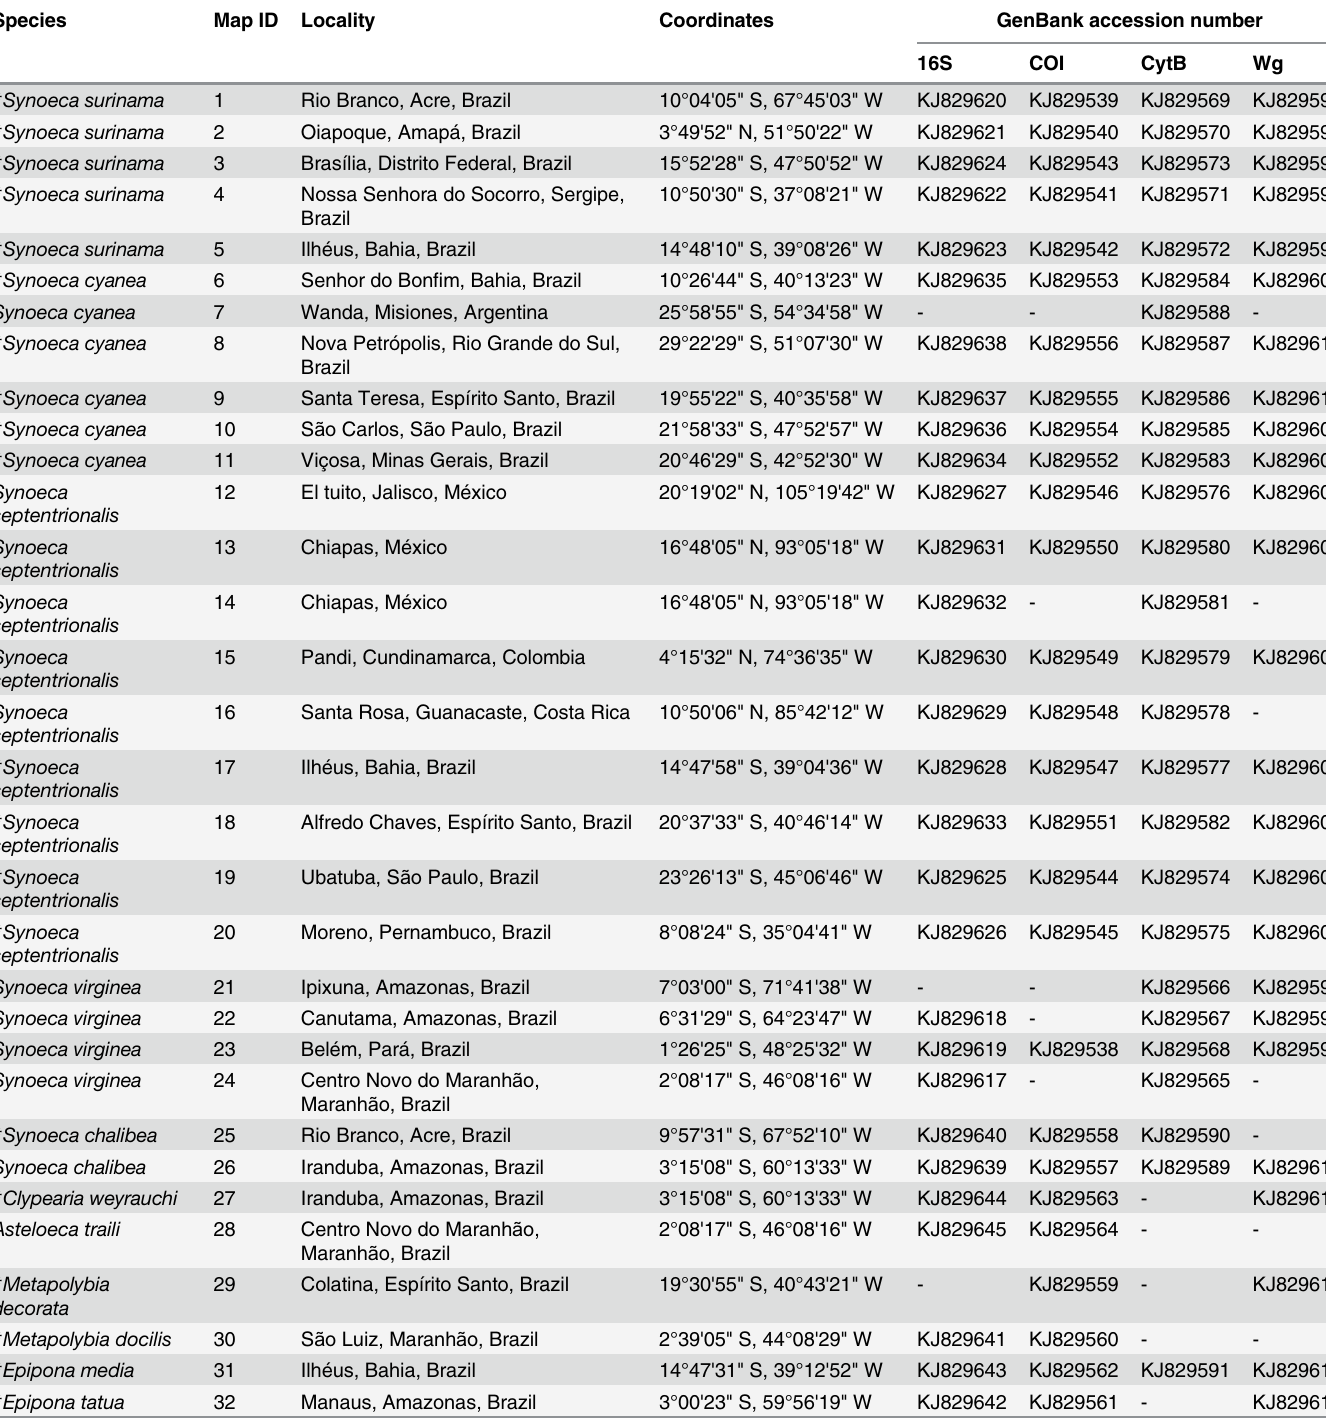
Table 1. Descriptive information for all taxa used in this phylogenetic study.